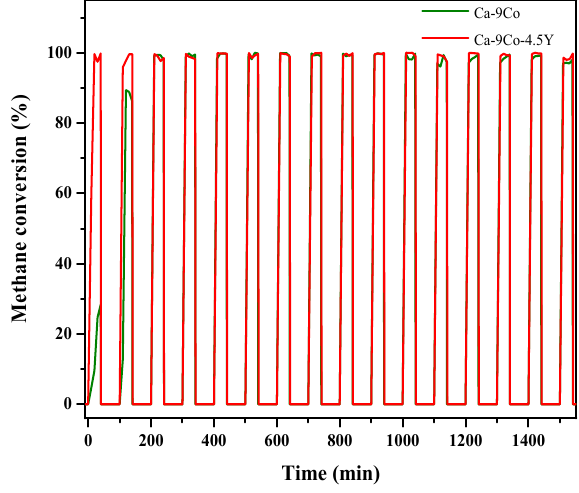
Figure 9. Life time of Ca ‐ 9Co and Ca ‐ 9Co ‐ 4.5Y samples during 16 redox cycles at 700 °C.